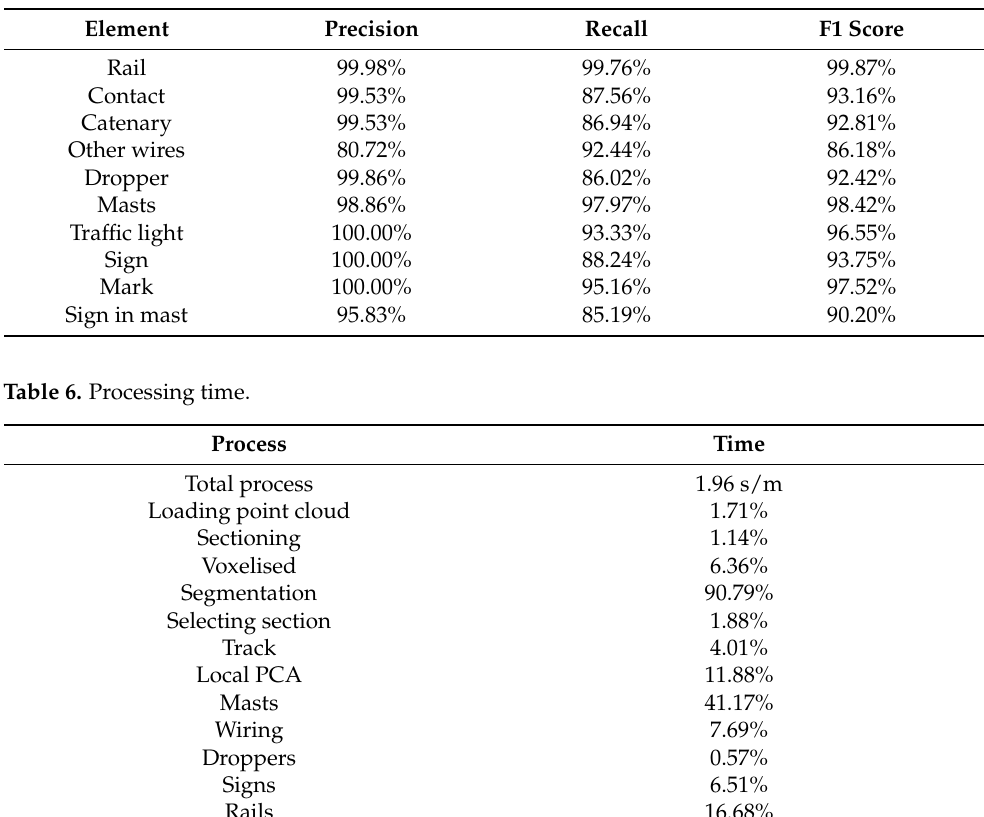
Table 5. Precision, recall, and F1 score.